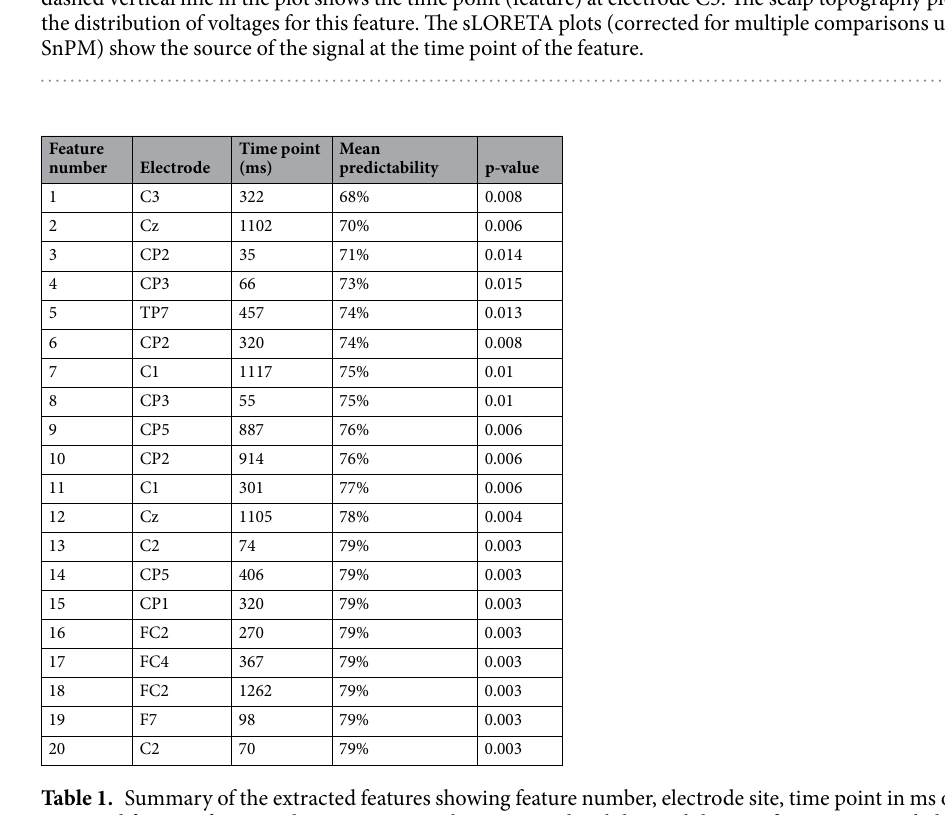
Table 1. Summary of the extracted features showing feature number, electrode site, time point in ms of the extracted feature after stimulus presentation, the mean predictability and the significance as provided from the t-tests used as a filter method in the feature selection